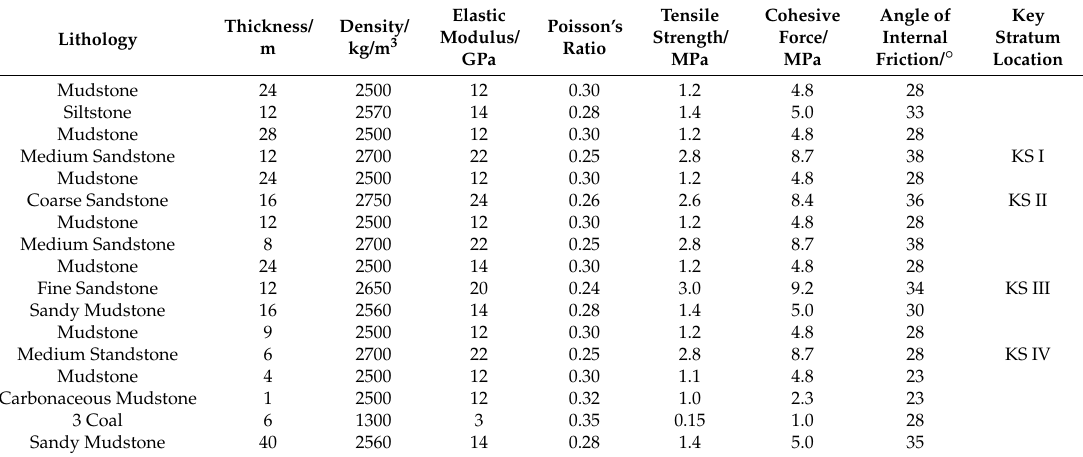
Table 1. Physical and mechanical parameters of